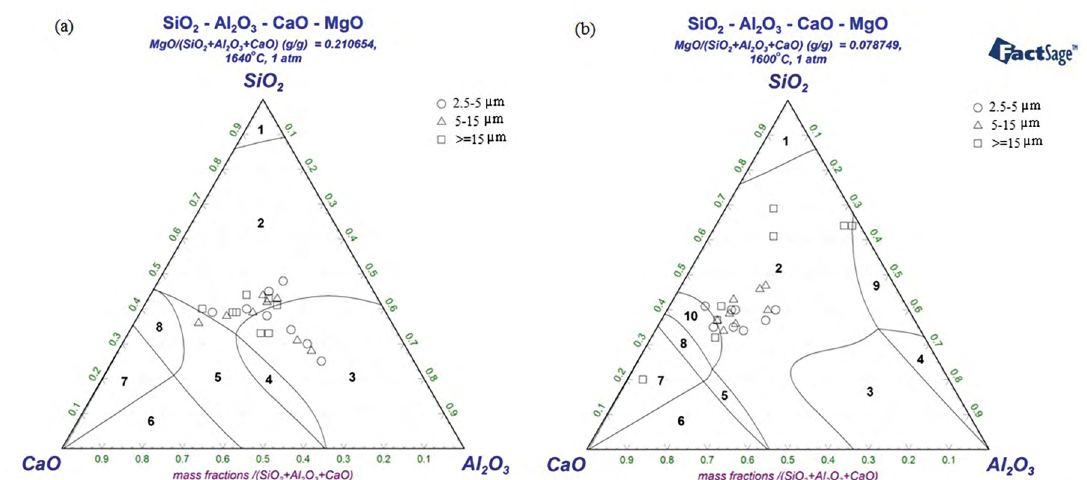
Figure 7. Inclusion distribution for each diameter range (µm) (a) before and (b) after vacuum treatment. Phases: 1 - ASlag-liq + ASlag-liq#2; 2 - ASlag-liq; 3 - ASlag-liq + ASpinel; 4 - ASlag-liq + ASpinel + (a) AMonoxide, (b) Mullite; 5 - ASlag-liq + AMonoxide; 6 - ASlag-liq + AMonoxide + AMonoxide#2; 7 - ASlag-liq + AMonoxide + AMonoxide#2 + a-Ca ASlag-liq + Mullite; 10 - ASlag-liq + a-Ca